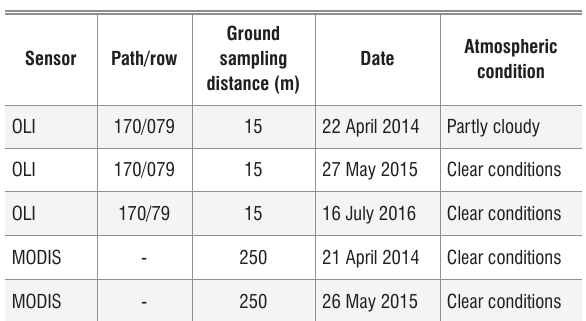
Specifications of the satellite data used in the study